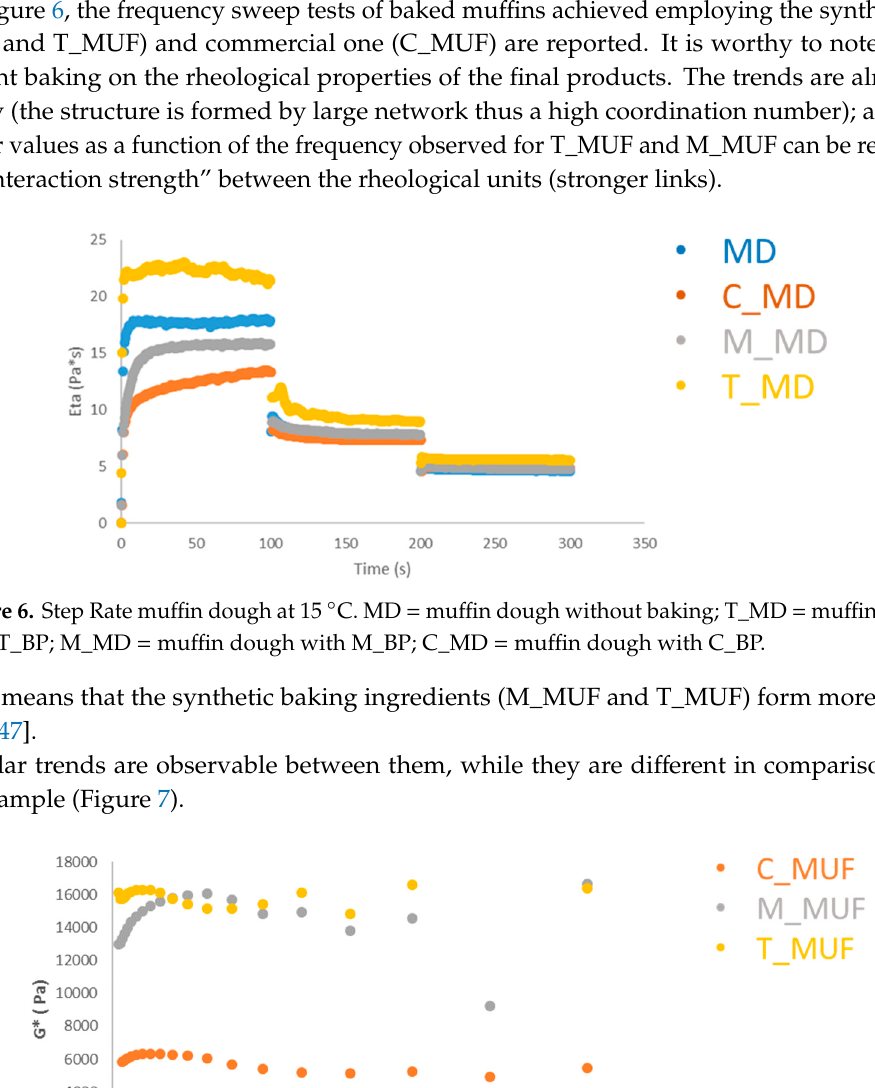
Figure 5. Frequency Sweep Test muffin dough (G *). ( a ): 15 °C, ( b ): 25 °C. MD = muffin dough without baking; T_MD = muffin dough with T_BP; M_MD = muffin dough with M_BP; C_MD = muffin dough with C_BP.